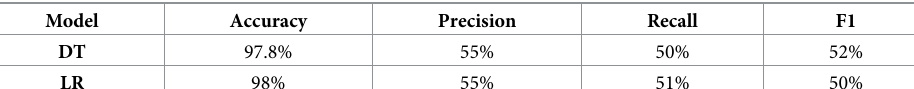
Table 8. Results of testing under poisoned